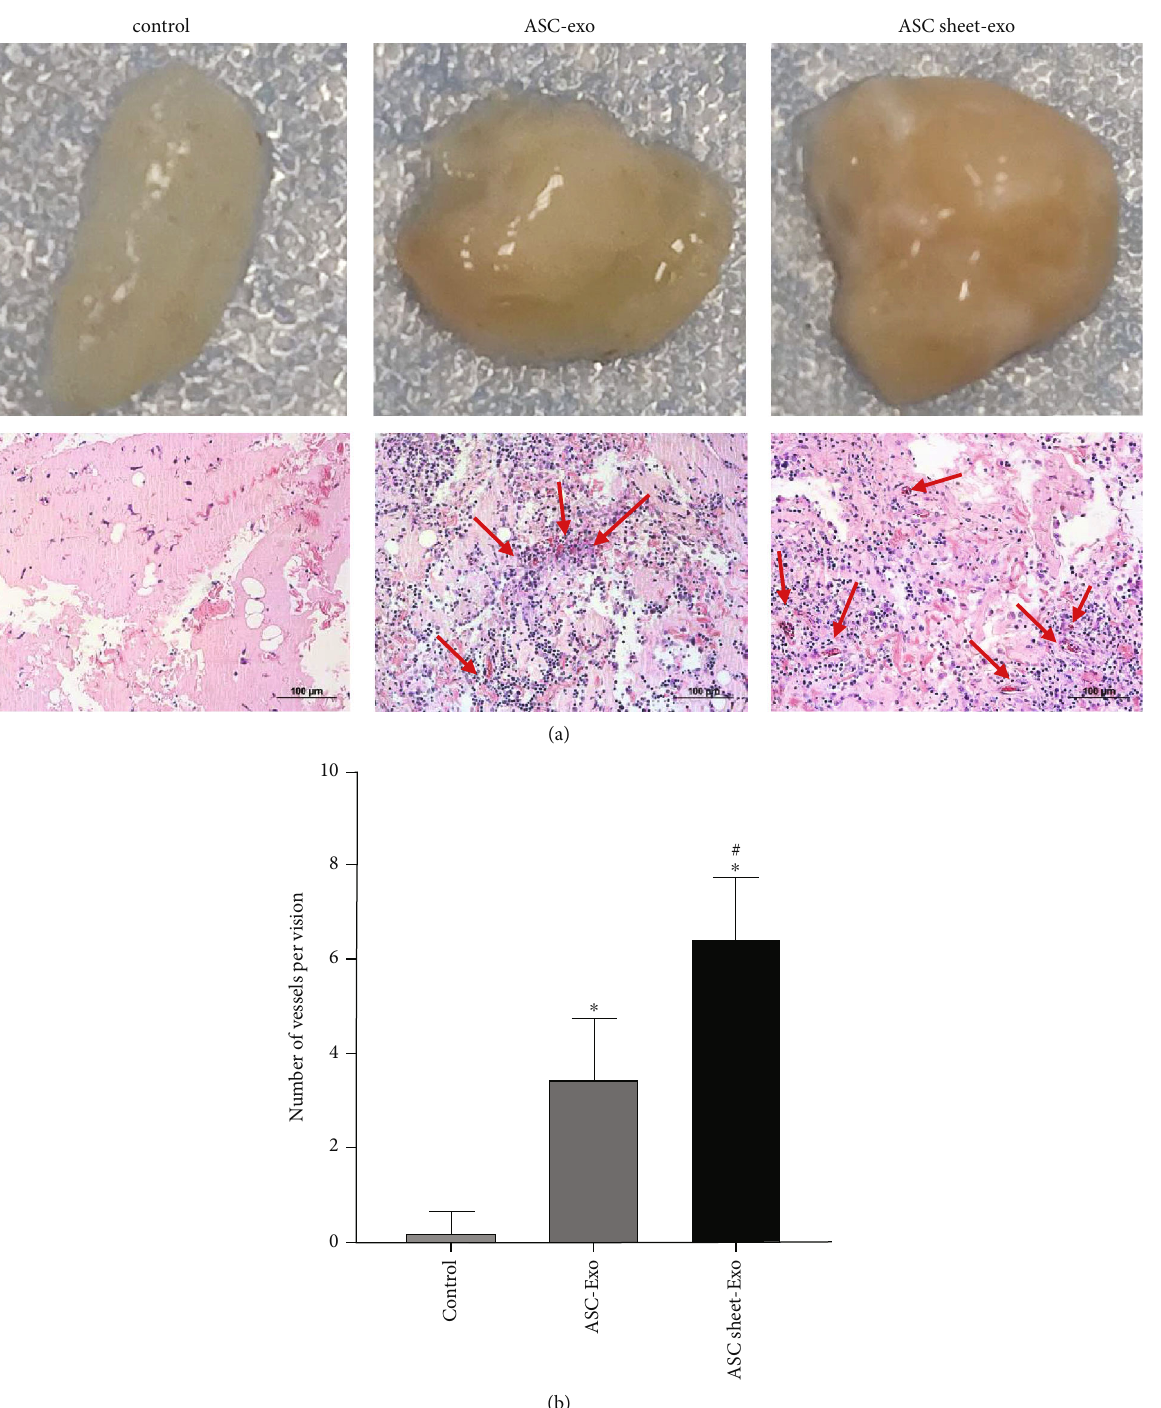
Figure 15: Angiogenic e ff ects of ASC-exo and ASC sheet-exo in Matrigel plug assay in vivo. (a) Macroscopic view of representative explants and microscopic examination of H&E-stained para ffi n sections at 3 weeks. Scale bars: 100 μ m. (b) Statistical analysis of microvessel number in Matrigel explants. ∗ p < 0 : 05 , versus the blank control group; # p < 0 : 05 , versus the control